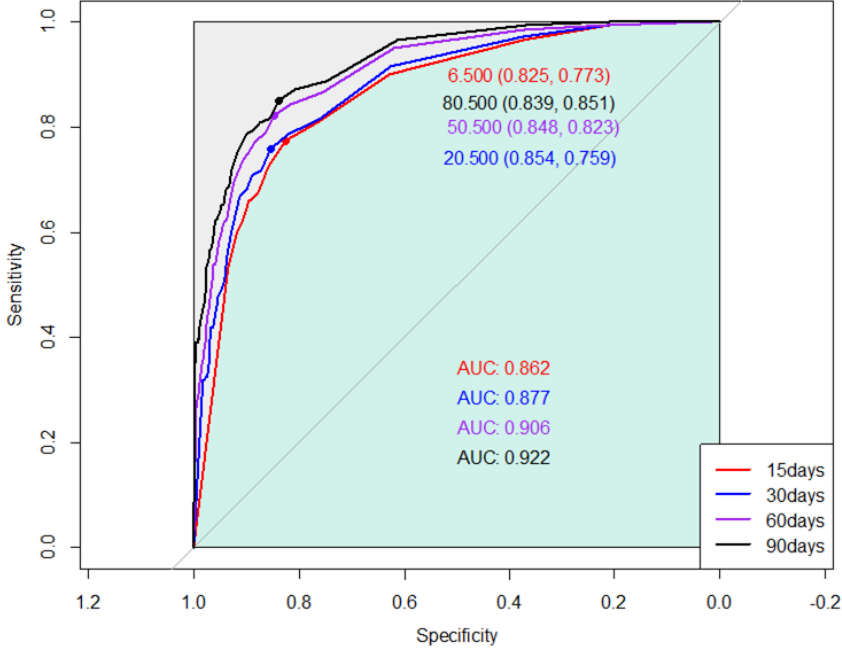
Figure 1. Receiver operating curves showing the association between one-year mortality and days alive and out of hospital (DAOH) at 15, 30, 60, and 90 days after hip replacement surgery. The readmission rate within 15 days after surgery was 0.6% (30/5356). The quartile values for DAOH at 15 postoperative days were 7, 9, and 10, respectively, and patients were divided accordingly. Table 1 presents the baseline characteristics and mortality of patients. Patients with a higher DAOH at 15 days postoperative tended to have a higher DAOH over longer follow-up periods and lower risk of